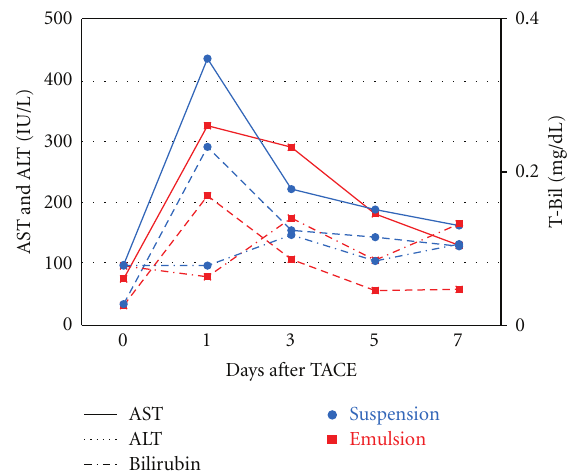
Figure 5: Levels of toxicity. AST and ALT levels increased for several days after TACE, and did not recover to baseline levels during the experimental period. Although the levels of the suspension group increased to a slightly greater extent compared to those of the emul- sion group, the di ff erences between the levels of the 2 groups did not reach a level of statistical significance. No significant changes were observed in the T-Bil level of either